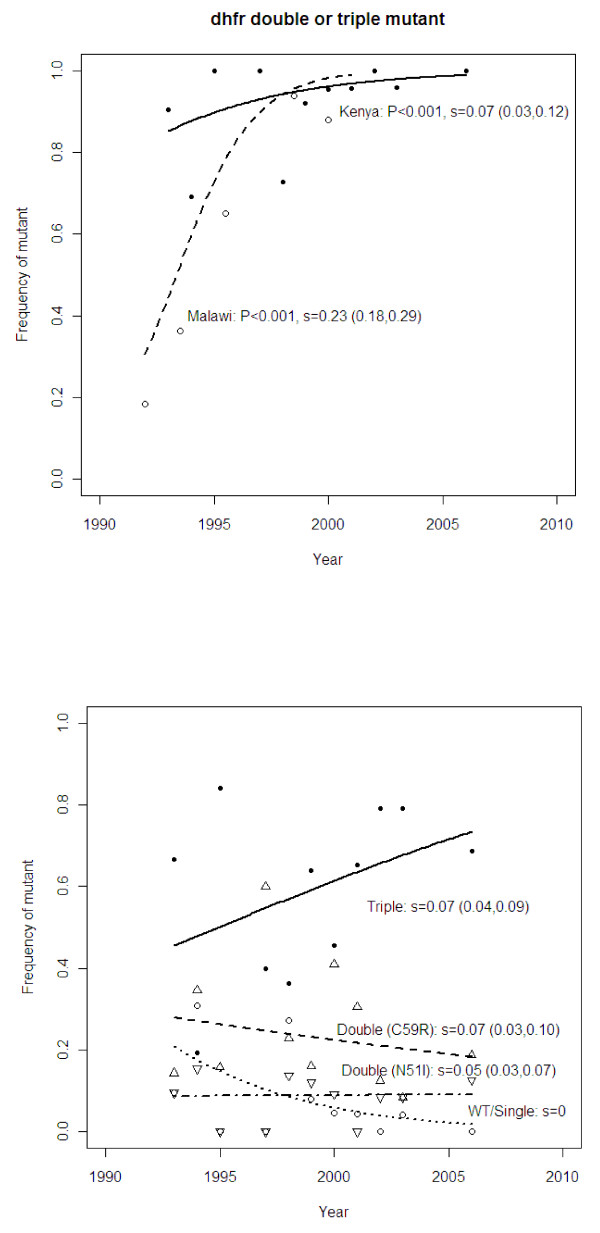
Observed and predicted frequencies of dhfr mutations through time in Kilifi, Kenya and a study in Malawi [3]. Observed (symbols) and predicted (lines) population frequencies through time of alleles at the dhfr locus determining resistance to pyrimethamine, one of the partner drugs in SP. This drug officially replaced CQ as the first line drug in 1990 and 1992 in Kenya and Malawi, respectively: however, in Kenya, it was used as a second line drug prior to the change from CQ. In the upper panel, the data are for the frequency of the double and triple mutant alleles combined whereas in the lower panel, the alleles are treated separately (see Methods). Selection coefficients are expressed relative to the wild-type/single mutant genotype.